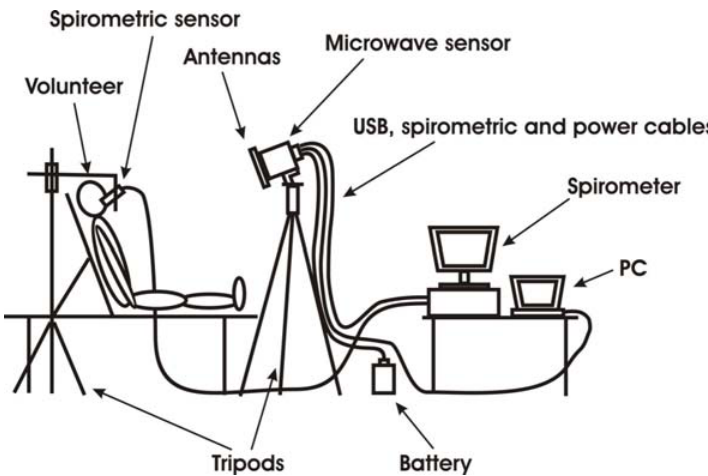
Figure 4. Sketch of the measurement